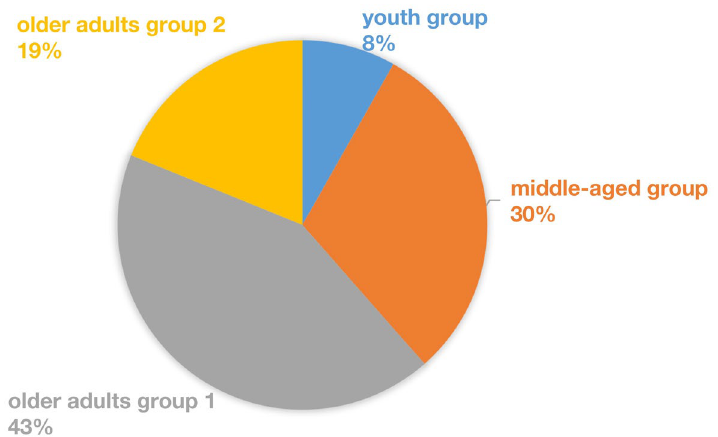
Figure 1. Age composition ratio of PPPD patients.